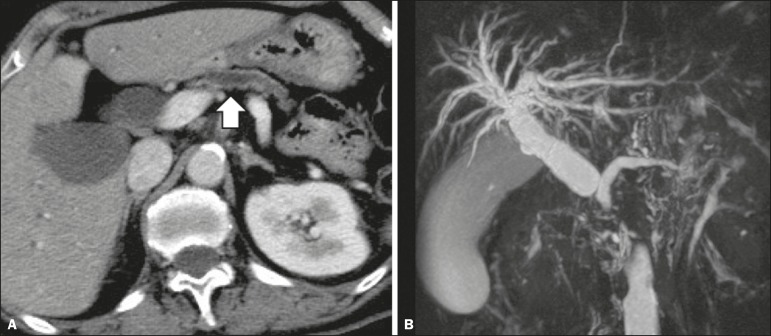
Contrast-enhanced CT (A) and magnetic resonance
cholangiography (B). Neoplasm of the pancreatic head,
causing dilatation of the main pancreatic duct (arrow in
A), with atrophy of the body and tail of the pancreas,
together with dilatation of the biliary tract.